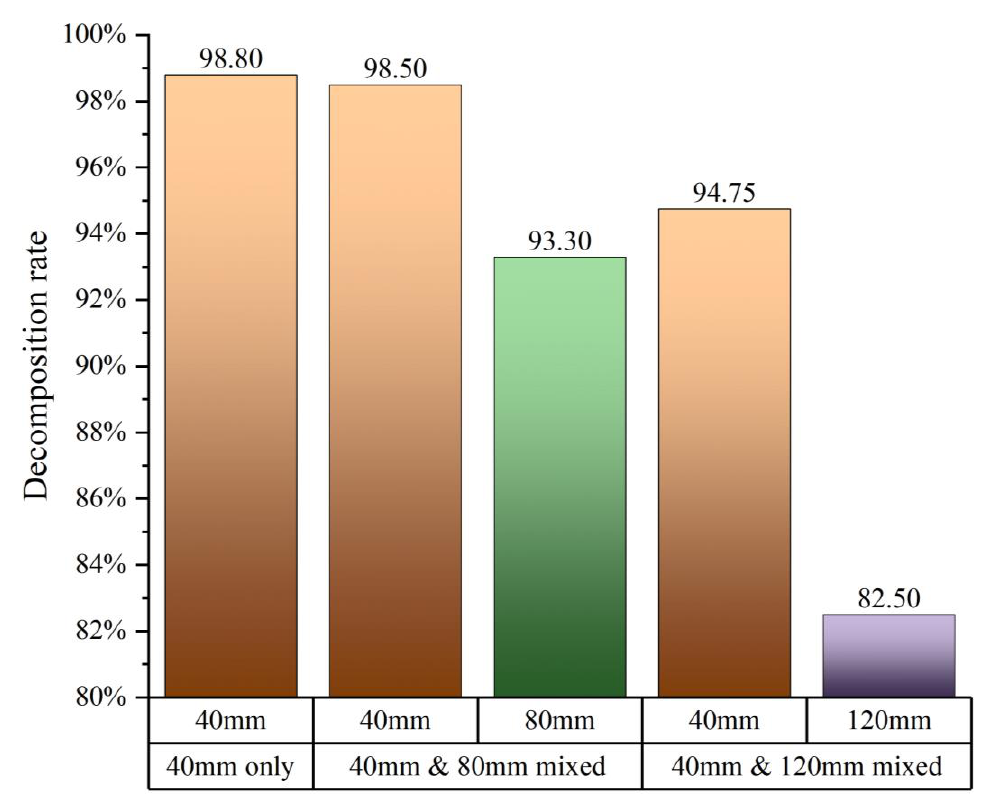
Figure 15. Comparison of decomposition rate under 40 mm uniform particle size, 40 + 80 mm mixed particle size, and 40 + 120 mm mixed particle size.